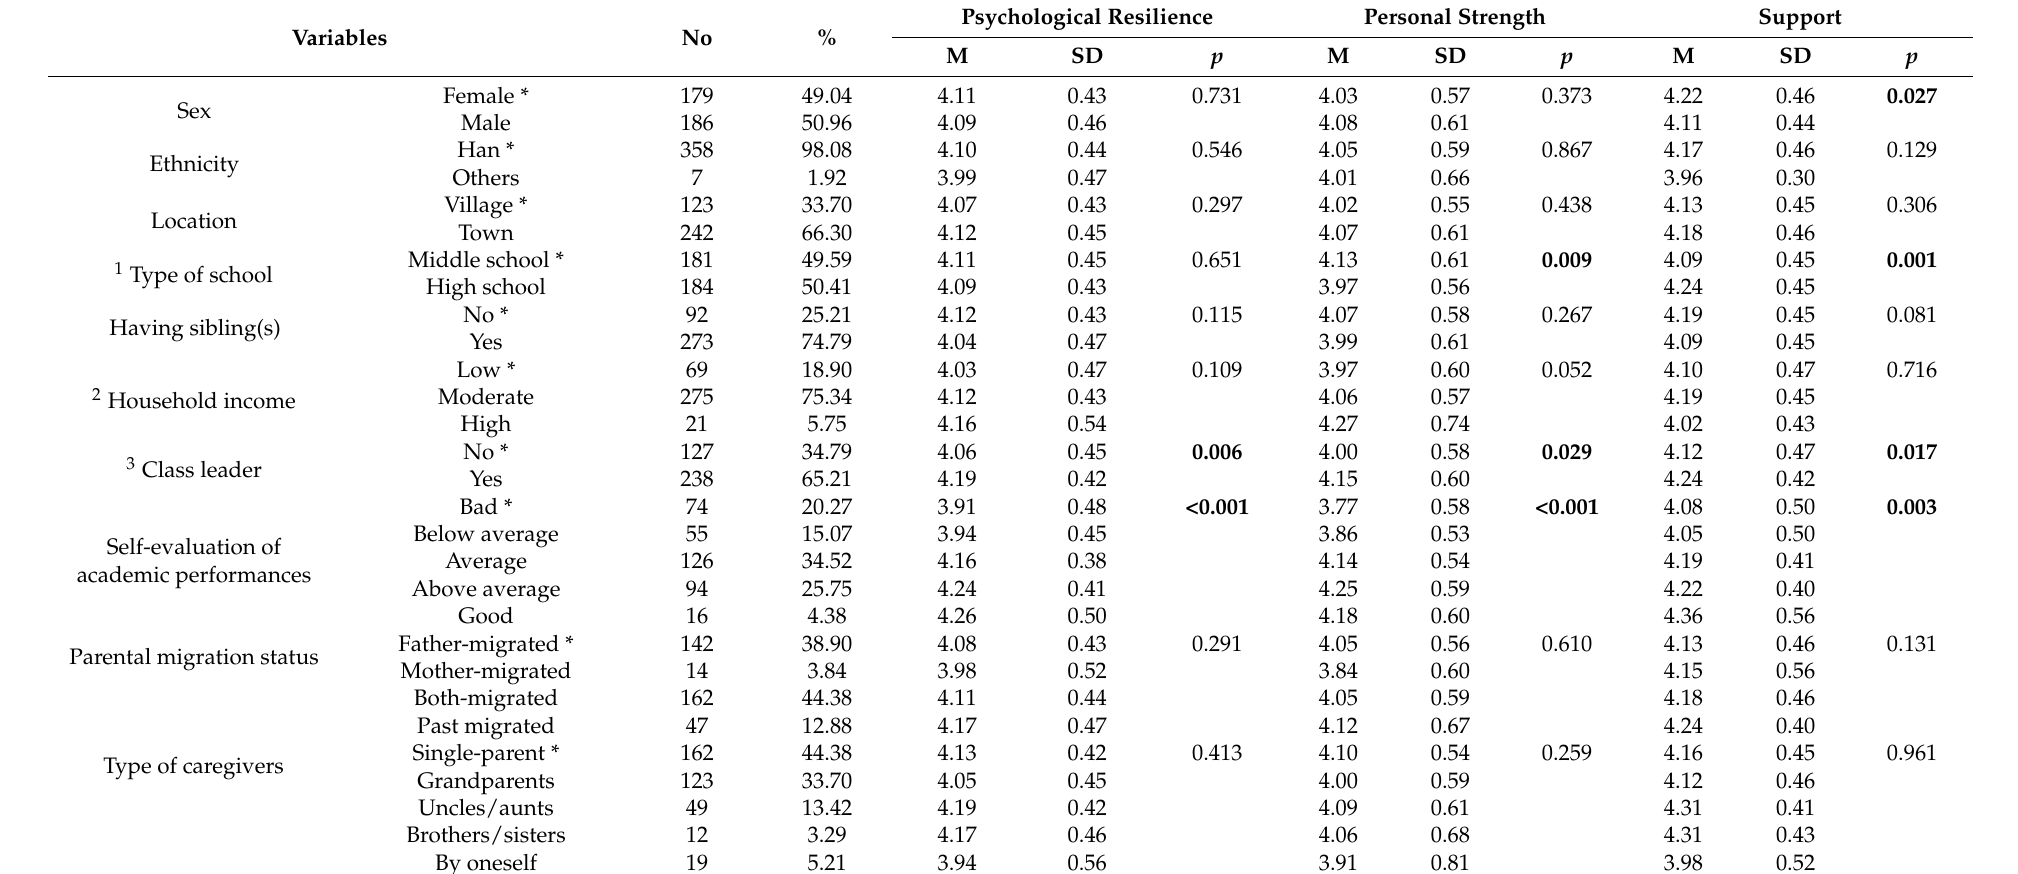
Table 3. Psychological resilience among left-behind